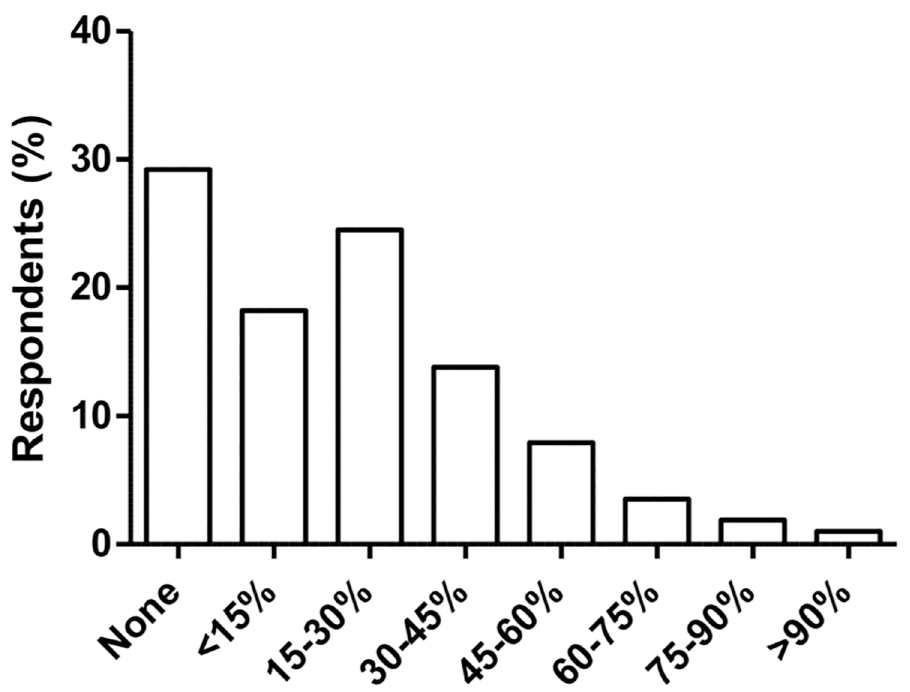
Fig 2. Physician perceptions on percentage of physicians who perform unnecessary procedures when they profit from them (N = 2,106).